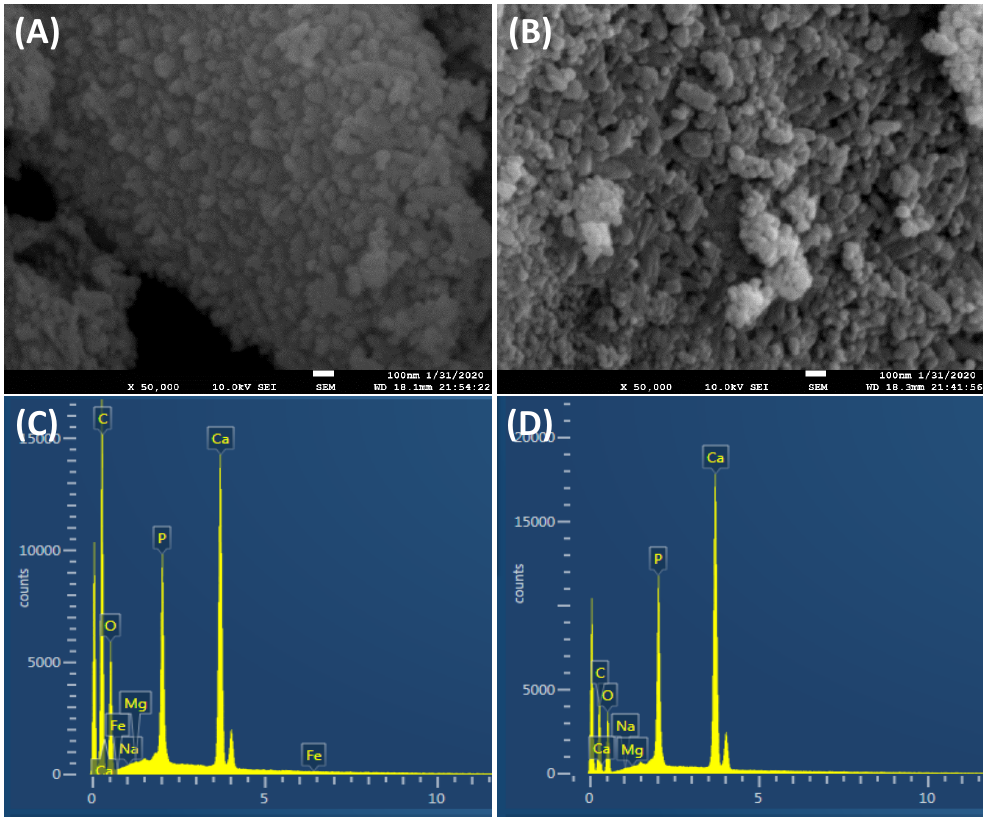
Figure 2. SEM ( A , B ) and EDS ( C , D ) of the biosynthesized BAp powder by employing FG seed extract. A and C are non-sintered, and B and D are sintered powder samples.